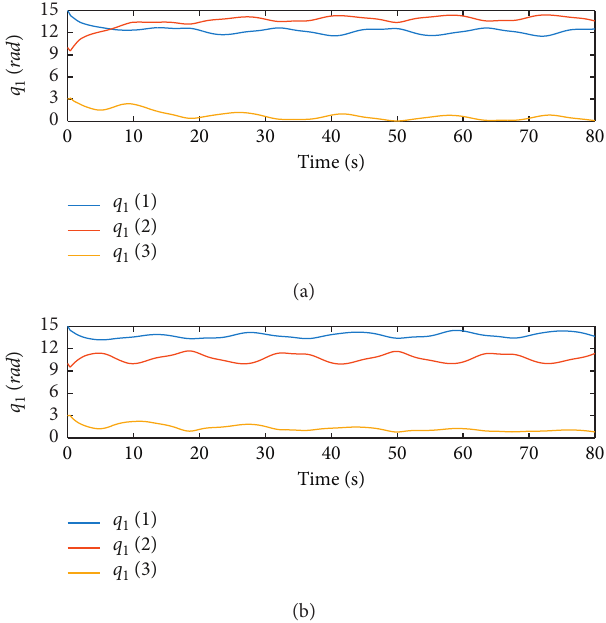
Figure 8: Joint-space coordinates of robot 1 with (a) and without (b) subtask